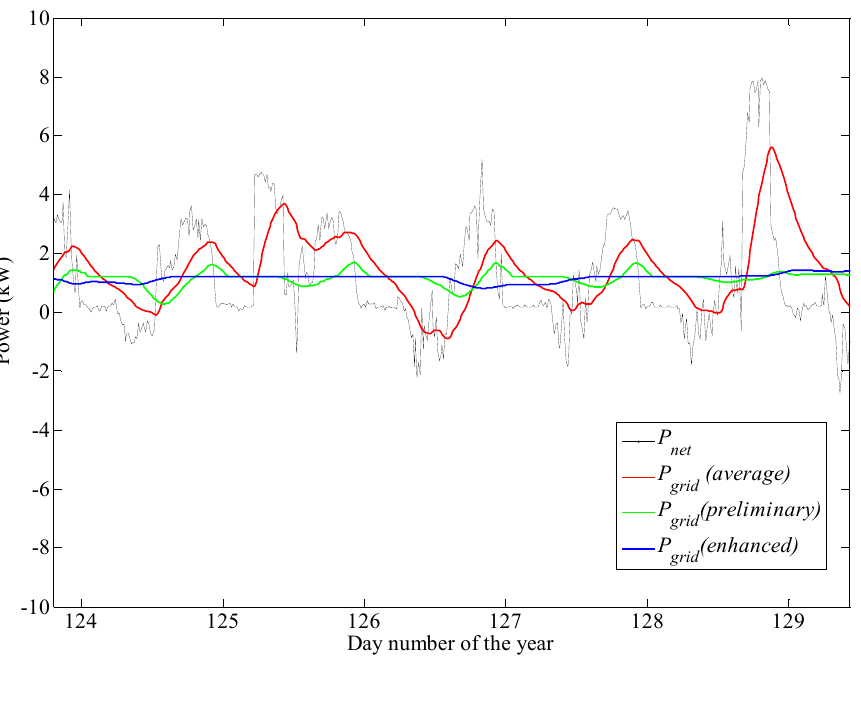
(average) (red), grid